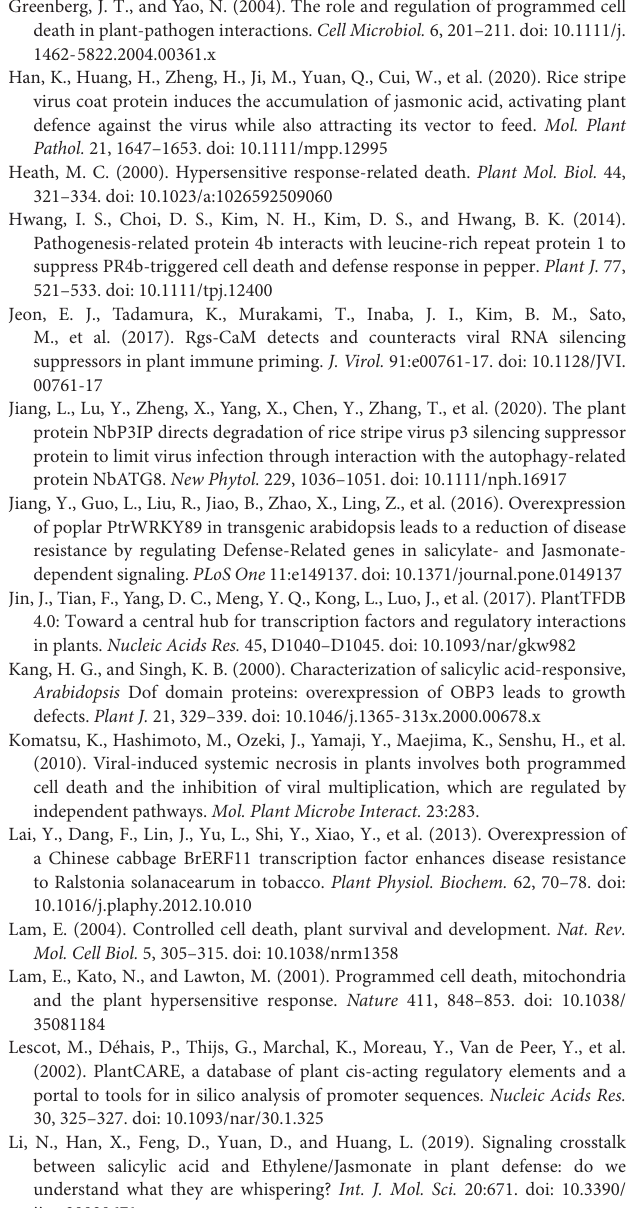
sequencing. Supplementary Table 4 | The MEME motif sequence and length of NbHRLIs. Supplementary Table 5 | Cis -acting elements in NbHRLIs . Supplementary Table 6 | Potential transcription factors of NbHRLIs. Supplementary Table 7 | Constructs used in Figures 7 , 8